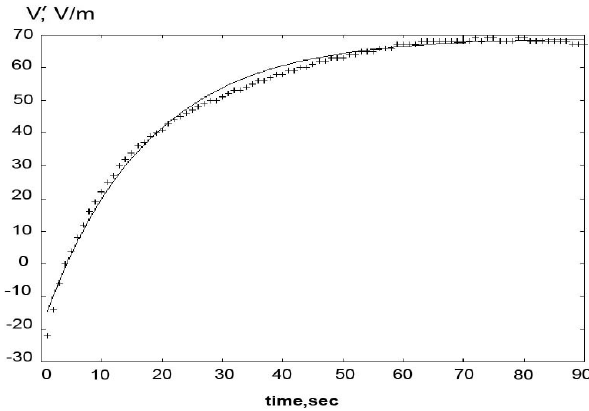
Fig. 4. Field recovery plot after lightning discharge (crosses) and Fig.4. Field recovery plot after lightning discharge (crosses) and approximation by the formula (2) (line). approximation by the formula (2) Simultaneously with electric field the acoustic emission response on lightning discharge was observed (Fig.5). Signal directly from the discharge was registered in the highest frequency range of 6.5 - 11 kHz (Fig.5, ellipse 1), and the following sound wave at all the channels (Fig.5, ellipse 2). According to